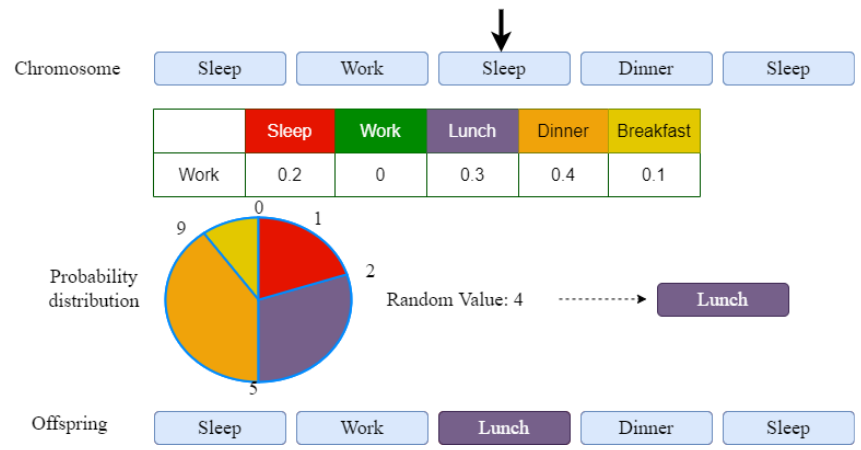
Figure 7. Example of applying mutation with weighted selection.